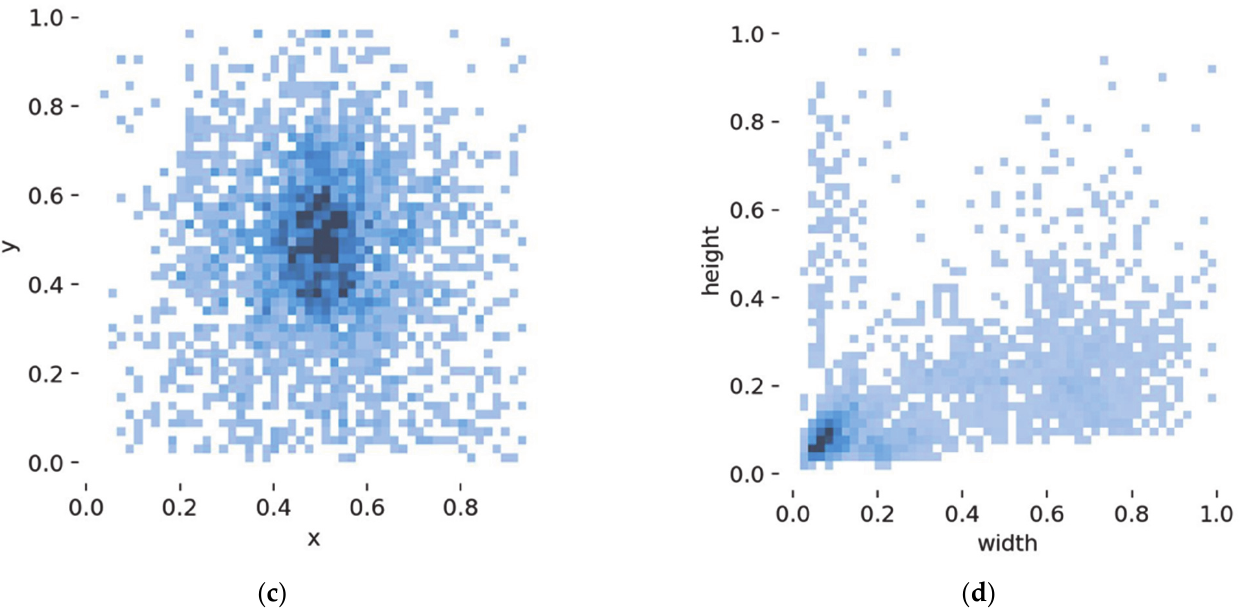
Figure 5. Data set analysis. ( a ) Number of insulators and defect labels. ( b ) Label visualization. ( c ) The center point of the label distribution. ( d ) Distribution of label aspect ratios. Table 2. Dataset label distribution table.